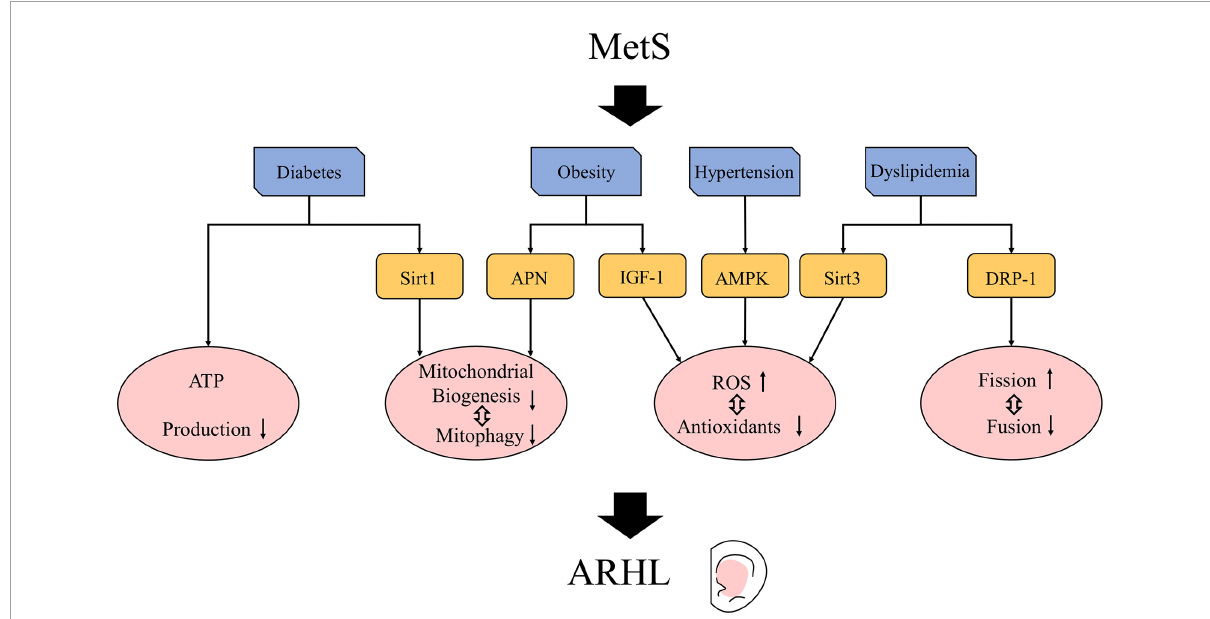
FIGURE2 Possible mechanisms by which metabolic syndrome (MetS) affects age-related hearing loss (ARHL). Mets may cause signal pathway and related factor changes, such as insulin-like growth factor 1 (IGF-1) (Riquelme et al., 2010; Alassaf et al., 2019), adenosine monophosphate-activated protein kinase (AMPK) (Zhao et al., 2020), sirtuins (Han and Someya, 2013; Hao et al., 2019; Pang et al., 2019; Miwa, 2021), adiponectin (APN) (Liu et al., 2019) and DRP-1 (Lin et al., 2019). These changes lead to mitochondrial changes so that can exacerbate